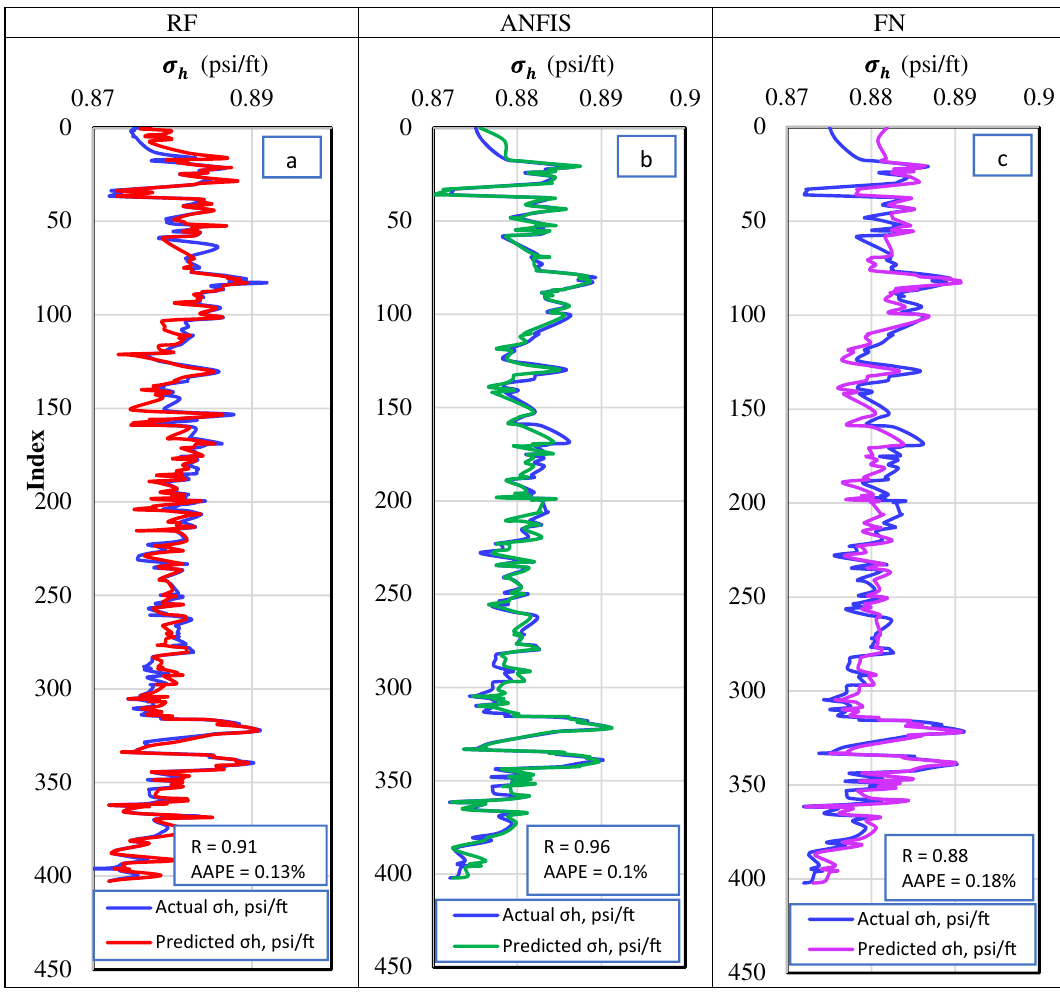
Figure 6. Actual versus the predicted σ h for the validation dataset from ( a ) RF model, ( b ) ANFIS model, and ( c ) FN model.